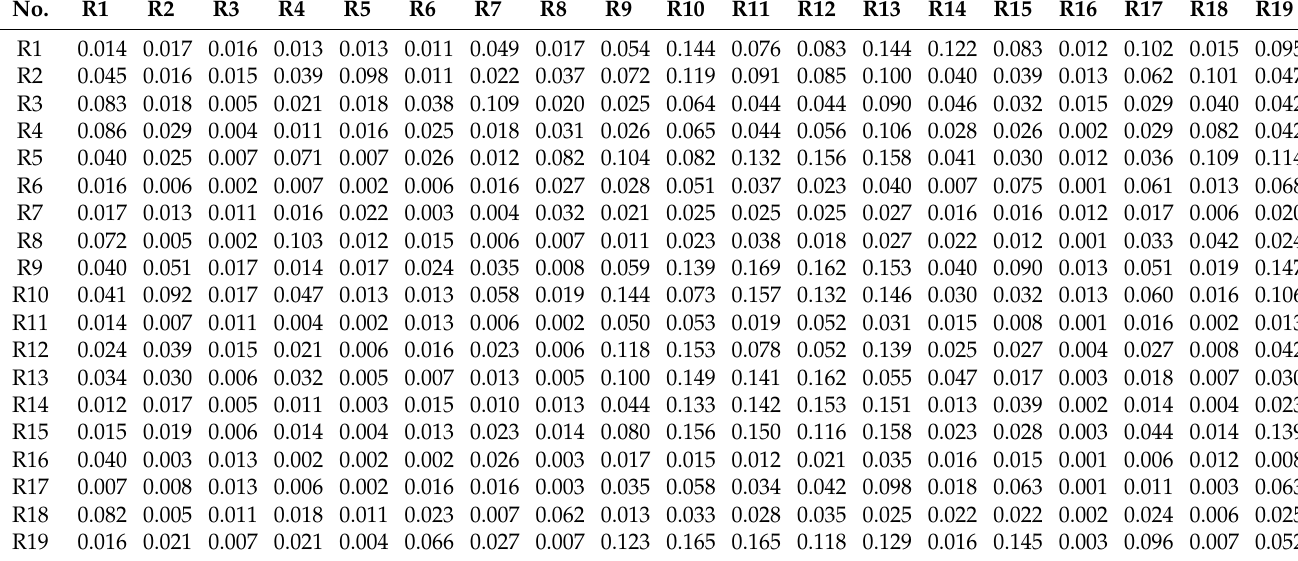
Table 14. The comprehensive influence matrix